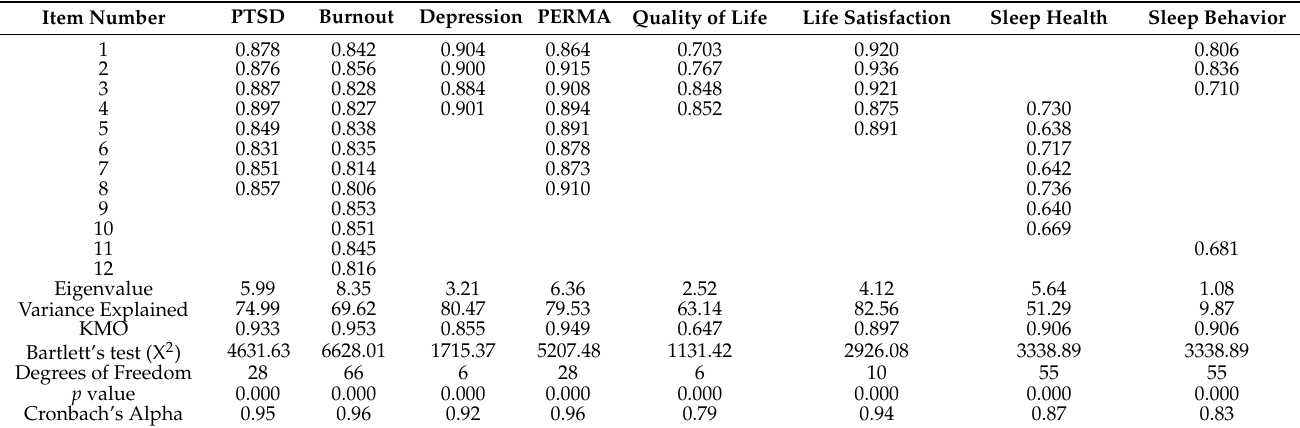
Table 1. Results of exploratory factor analysis ( N =